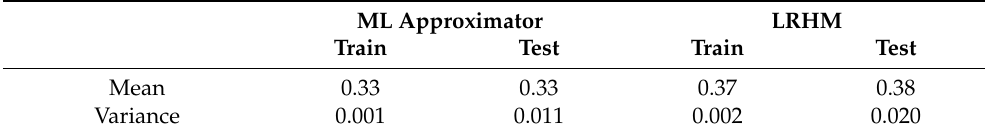
Table 4. Mean value and variance of the ML approximator loss function and LRHM performance metric in the Nyangores River case study.